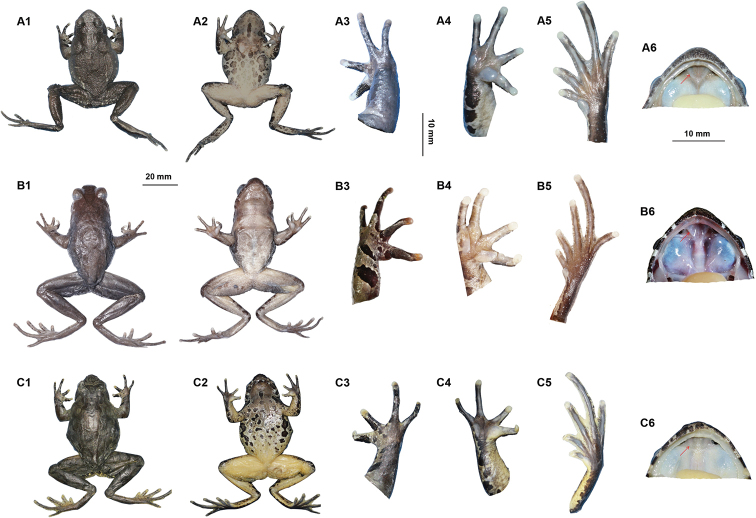
Photos of specimens of Megophrys
qianbeiensis sp. nov., M.
sangzhiensis and M.
spinataA1–A6 dorsal view, ventral view, dorsal view of hand, ventral view of hand, ventral view of foot and view of oral cavity of the holotype specimen CIBTZ20190608017 of Megophrys
qianbeiensis sp. nov. B1–B6 dorsal view, ventral view, dorsal view of hand, ventral view of hand, ventral view of foot and view of oral cavity of CIBSZ2012062005 of M.
sangzhiensisC1–C6 dorsal view, ventral view, dorsal view of hand, ventral view of hand, ventral view of foot and view of oral cavity of CIBLS20190801001 of M.
spinata. Arrow point to vomerine ridge.